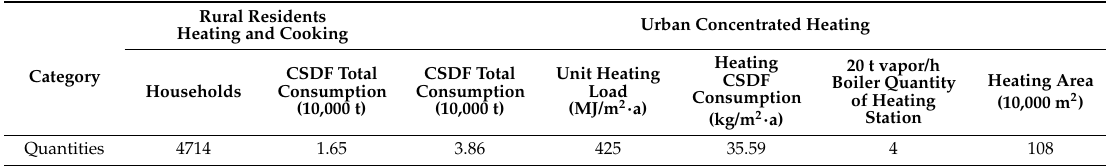
Table 7. Technical process of CSDF utilization.